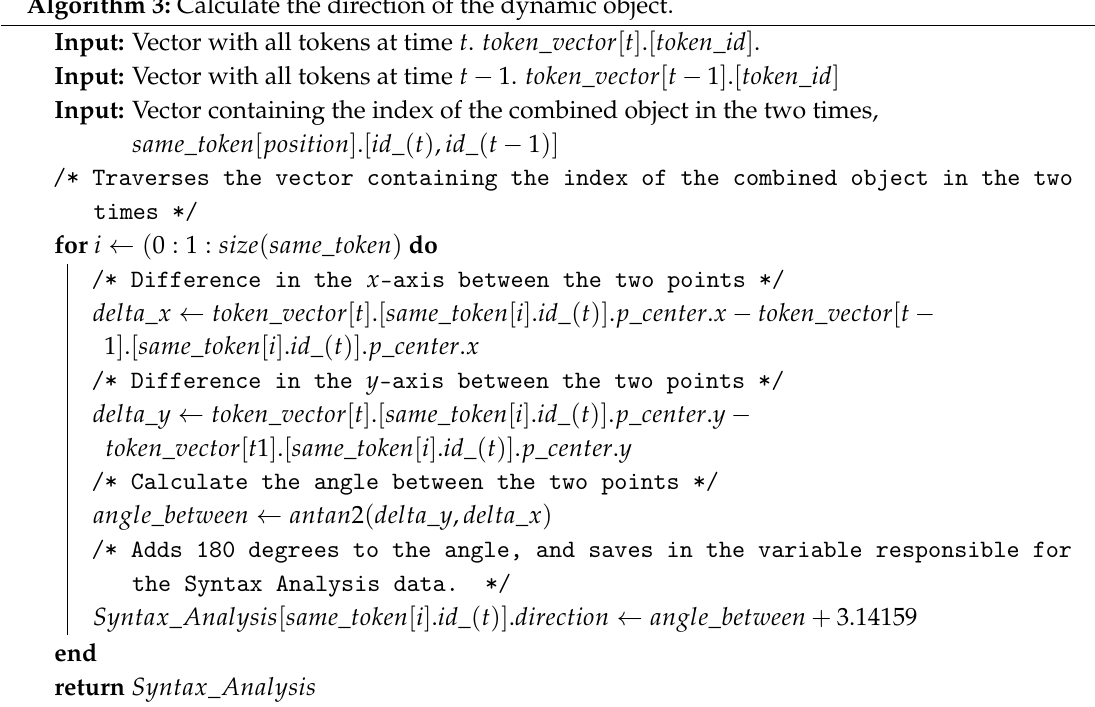
Algorithm 3: Calculate the direction of the dynamic